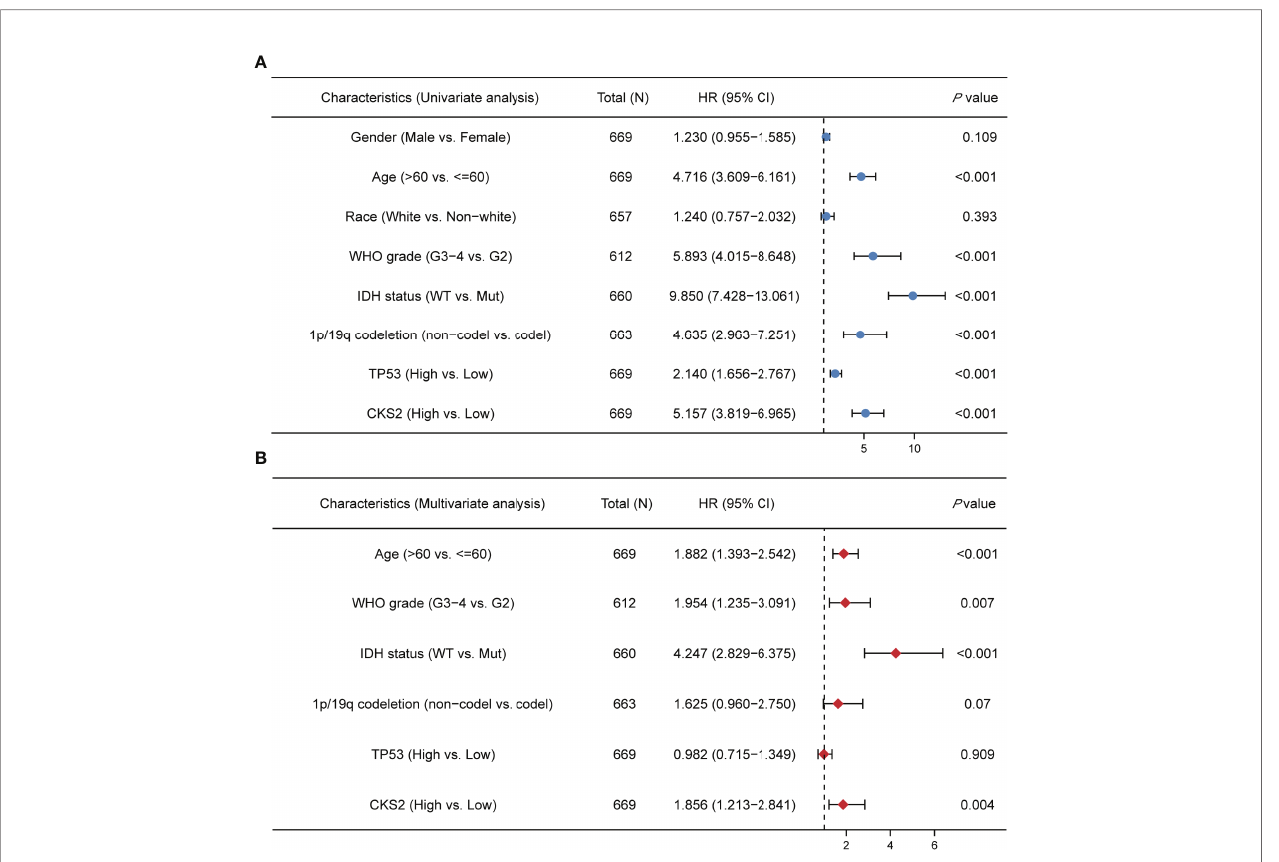
FIGURE 2 | Univariate and multivariate COX regression analysis of CKS2 expression and related clinical factors on overall survival of glioma patients. (A) On the basis of the TCGA database, univariate Cox regression showed that CKS2, age, WHO grade, IDH status, TP53, and 1p/19q co-deletion were associated with overall survival (OS). (B) Multivariate analysis showed that CKS2 mRNA expression, age, histological grade, WHO grade, and IDH status were independent prognostic factors for OS in